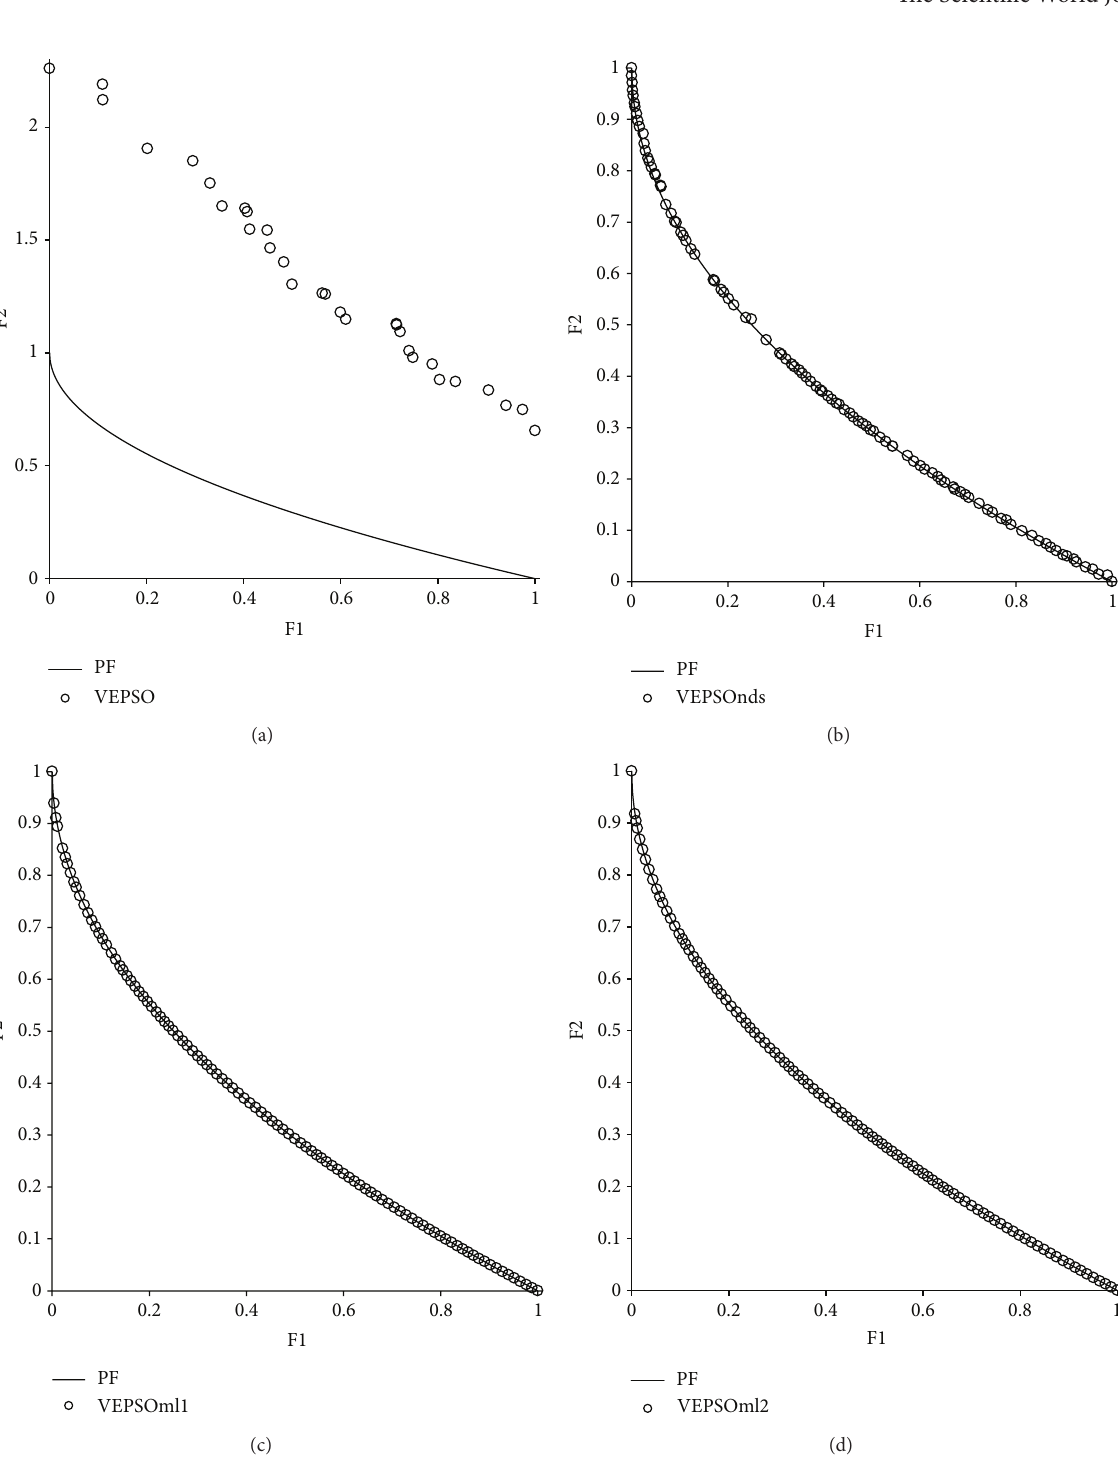
measure. Similarly, by the GD measure, VEPSOnds1 shows a small improvement, whereas VEPSOnds2 and VEPSOml1 show a larger improvement over the performance of